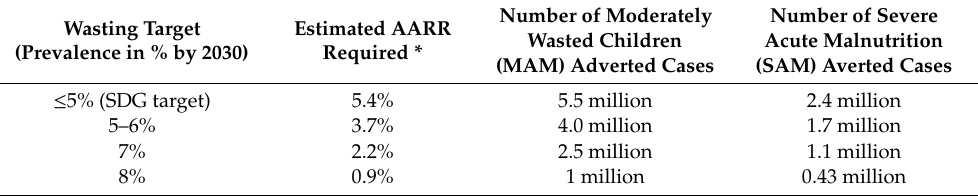
Table 2. Potential scenarios of averted cases of wasting in the next 10 years